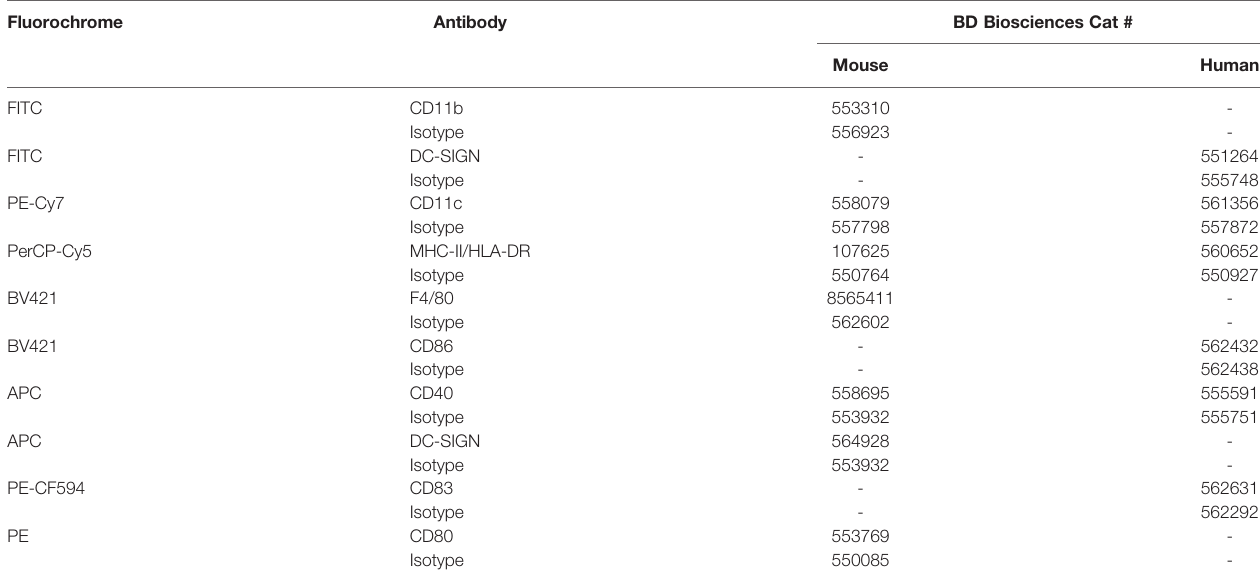
TABLE 3 | Antibodies used for fl ow cytometry.